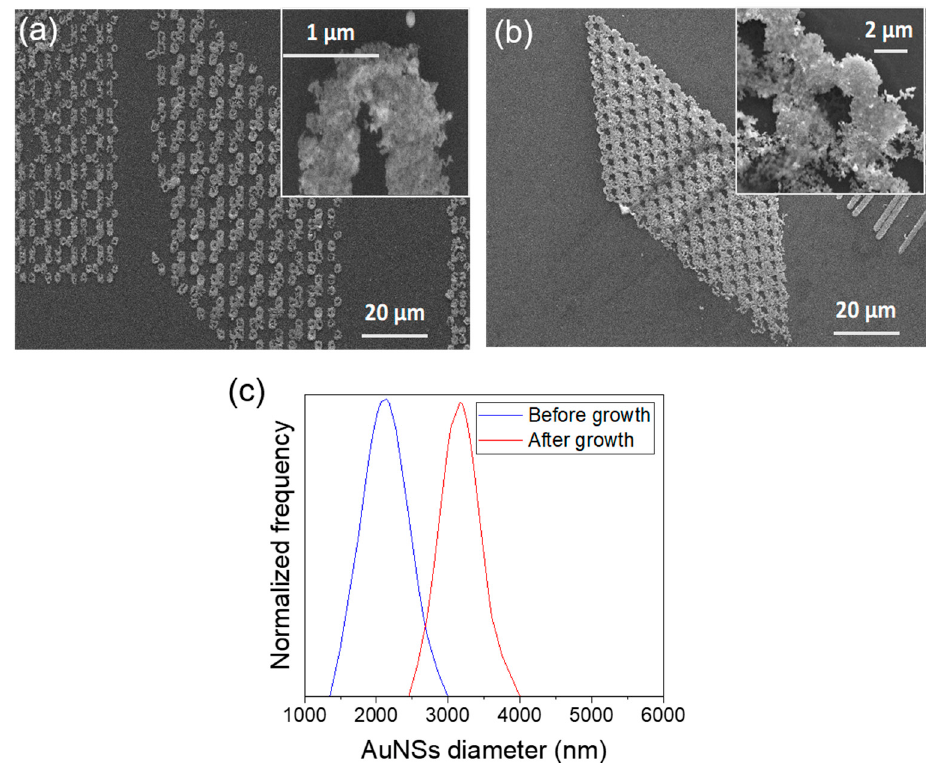
Figure 6. SEM images of the nanopatterns ( a ) before and ( b ) after AuNSs’ growth by immersion in a 10 − 2 M HAuCl 4 bath for 30 min. ( c ) Distribution of the AuNSs’ size before growth (blue, N = 29) and after growth (red, N = 26).